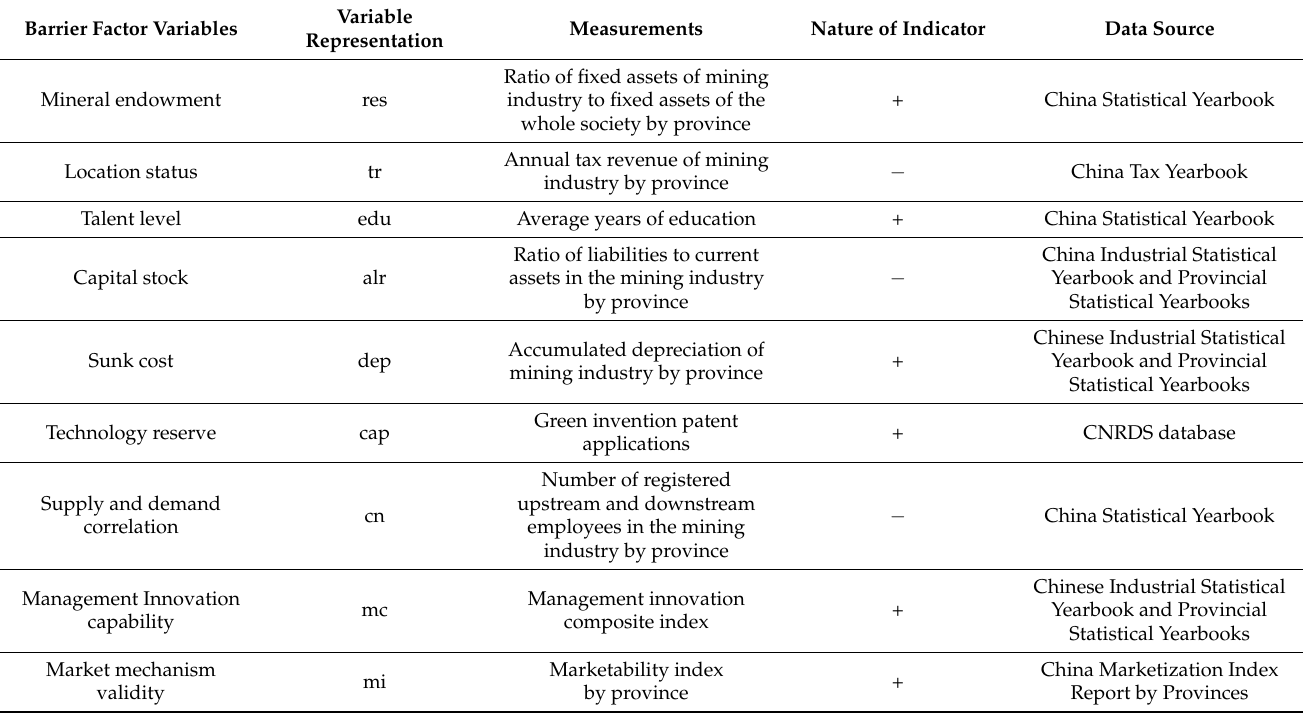
Table 2. Setting and description of the barrier factor